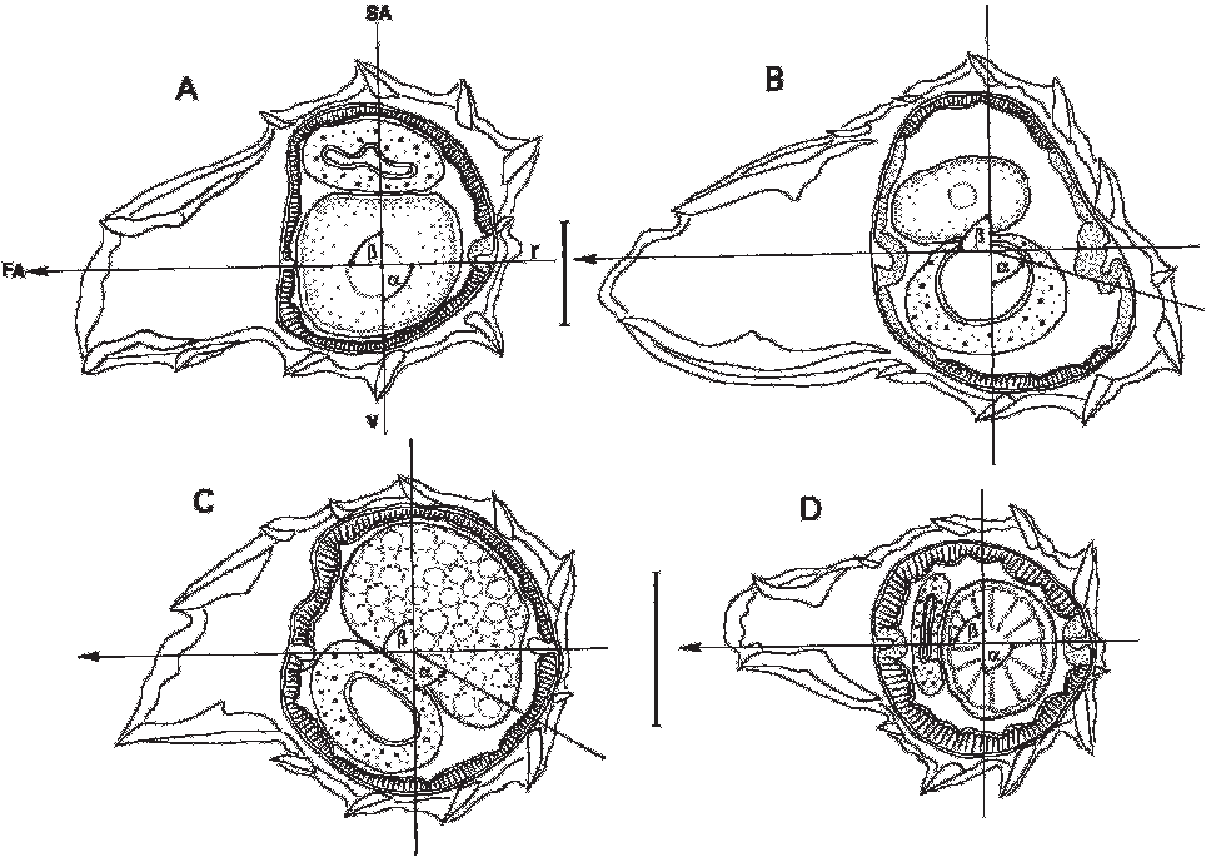
Fig. 1 – Transverse sections at mid-body of four species of the genus Vexillata Travassos, 1937. A. V. chabaudi Yoyotte-Vado, 1972, syn- type female, 8.7 mm long, section at 4.5 mm from apex; α = β = 90°. B. V. dessetae Denké, 1977, syntype female, 9.0 mm long, section at 5 mm from apex; α = 73°, β = 90°. C. V. legallae Denké, 1977, syntype female, 3.7 mm long, section at 2.1 mm from apex; α = 60°, β = 90°. D. V. petteri Durette-Desset, 1970a, syntype male, 3.2 mm long, section at 1.5 mm from apex; α = β = 90°. All sections are orientated as A. Axis (axes) of orientation represented by the arrow. α : angle of inclination of the right axis to the sagittal axis. β : angle of inclination of the left axis to the sagittal axis. Abbreviations: r: right side; v: ventral side; SA: sagittal axis; FA: frontal axis passing through the lateral fields. Scales: 30